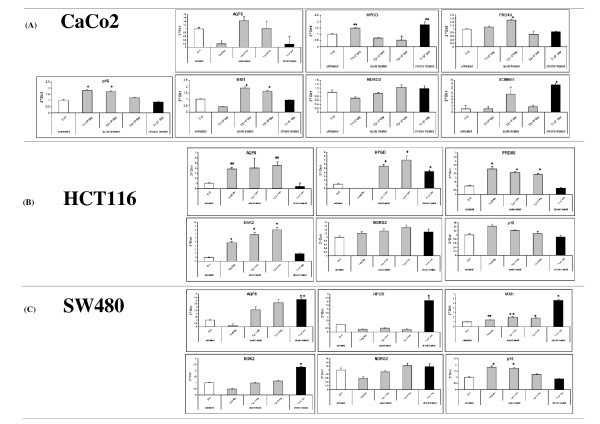
Histograms depict expression levels of AQP8, HPGD, PRDX6, MXI1, NDRG2, SCNNB1 and SGK2 genes in CaCo2 cell line (A), HCT116 cell line (B) and SW480 cell line (C) before and after exposure to 5-Aza-CdR determined by quantitative real-time PCR using the Comparative CT method. 2^DCt indicates the ratio between the values of CT normalized to three housekeeping genes and compared to cDNA of untreated cells used as calibrator. Error bars indicate standard deviation from triplicate experiments. p16 gene was used as positive control in the experiments. Statistical significance threshold p-value (p < 0.001) for both acute and chronic treatment are shown. Asterisks indicate P < 0.05 values and double asterisks indicate P < 0.001 values.